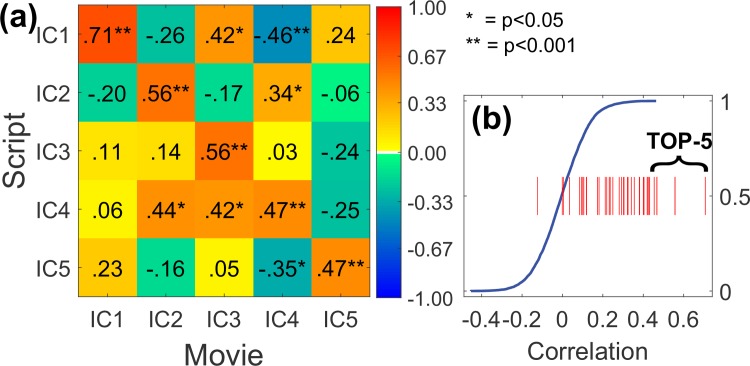
Temporal correlations between movie and script conditions for TOP-5 components.(a): Each row (column) corresponds to a group-averaged IC time-courses for the script (movie) condition. Statistically significant correlation coefficients are marked with stars (p<0.05 and p<0.001; FDR adjusted over 5×5 = 25 elements). (b) Component-wise matched correlation coefficients (red lines; one for each component, 40 values) plotted against the cumulative empirical null-distribution (blue line). Highest five correlations correspond to TOP-5.